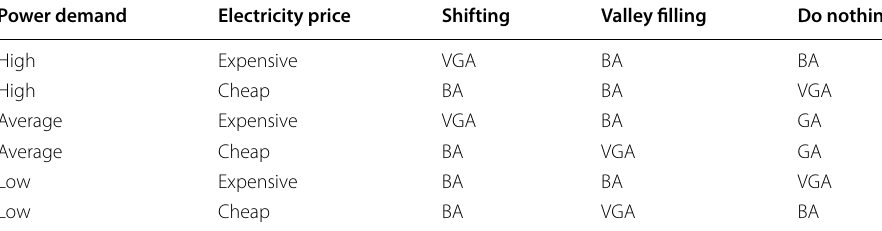
BA bad action, GA good action, VGA very good